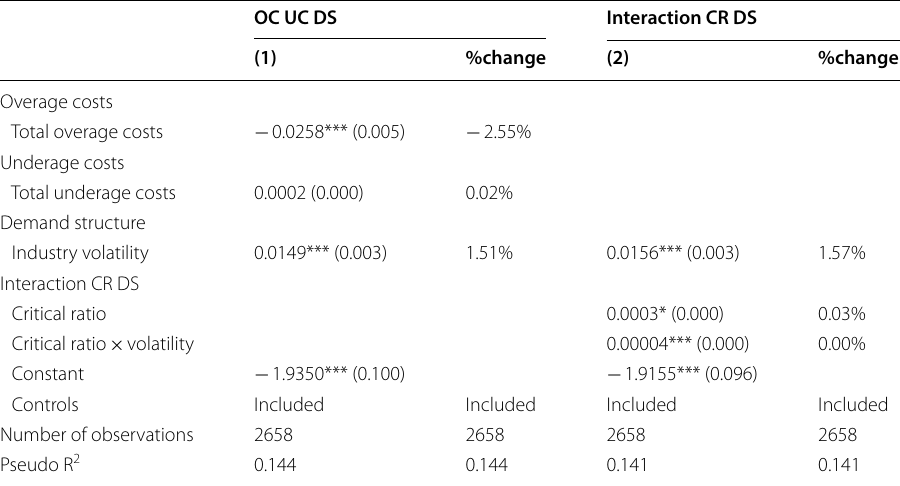
Table 5 Main determinants of the training intensity for training-firms. Source BIBB CBS 2012/2013